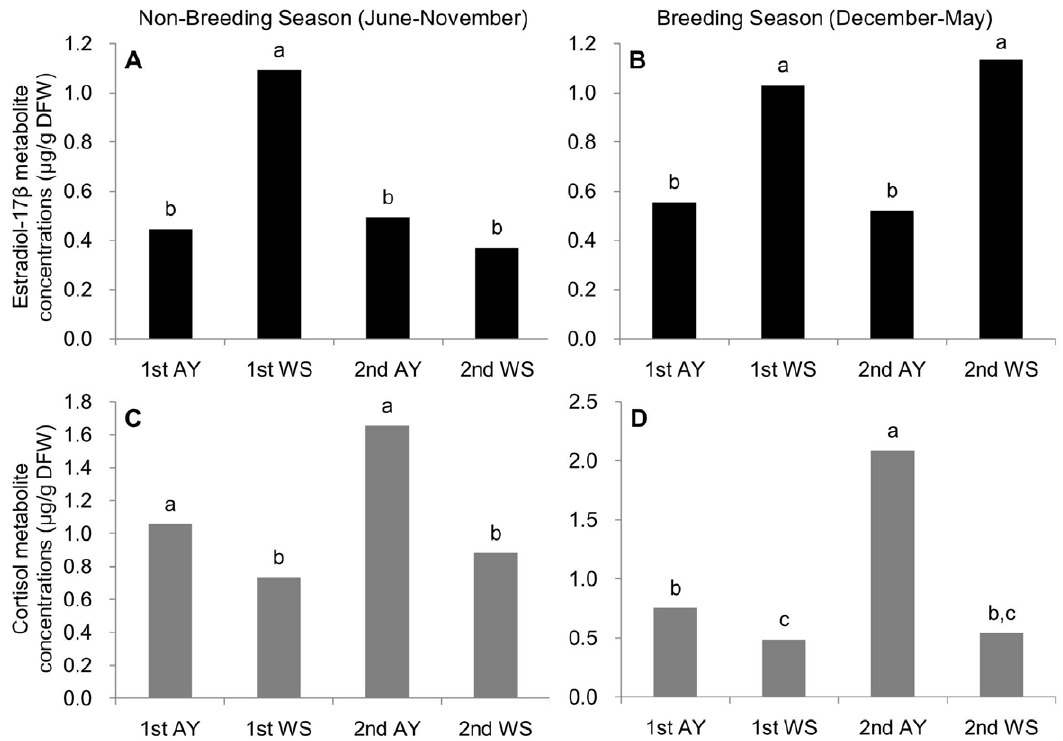
Figure 4. Median values of fecal estradiol-17 b (A: non-breeding season, B: breeding season) and cortisol metabolite concentrations (C: non-breeding season, D: breeding season) in female C. AY and WS are abbreviations for the style of housing condition, AY: living all-year with a male (1 st and 2 nd AY are the years 2006 and 2008), WS: living only during the winter season with a male (1 st and 2 nd WS are the years 2007 and